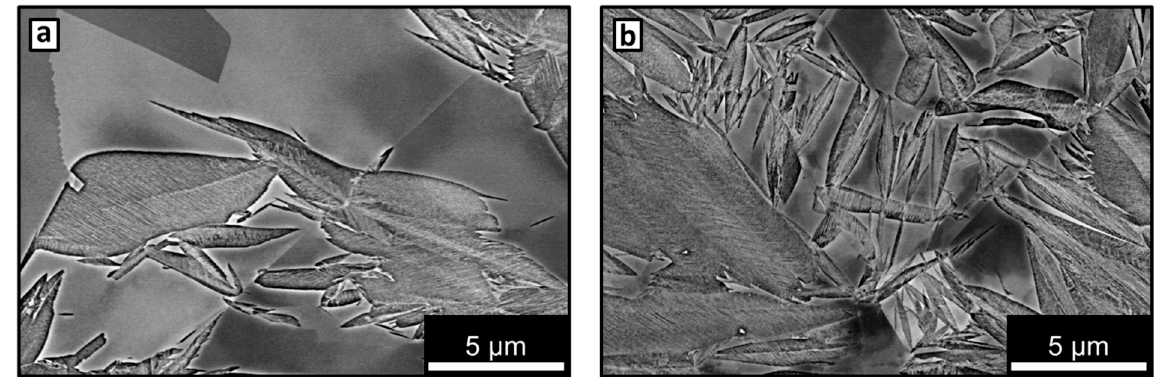
Figure 1. Microstructure of the lenticular martensite in ( a ) FeNiC and ( b ) FeNiCSi by means of backscatter electron imaging, respectively.